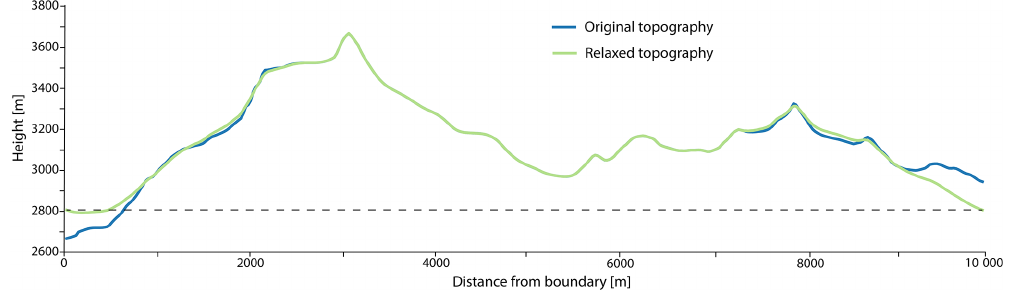
Figure 2. Adaption and relaxation of the computational domain. The blue and green lines show a east–west profile of the original and relaxed topography, respectively. The boundary grid cells have been set to the mean value of both cells (dashed line). The adjacent grid points are slowly relaxed (exponentially) to get a smooth transition from the boundaries towards the inner domain using a spline